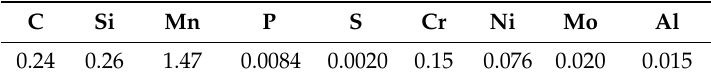
Table 1. Chemical composition of 20Mn5 steel (wt %).